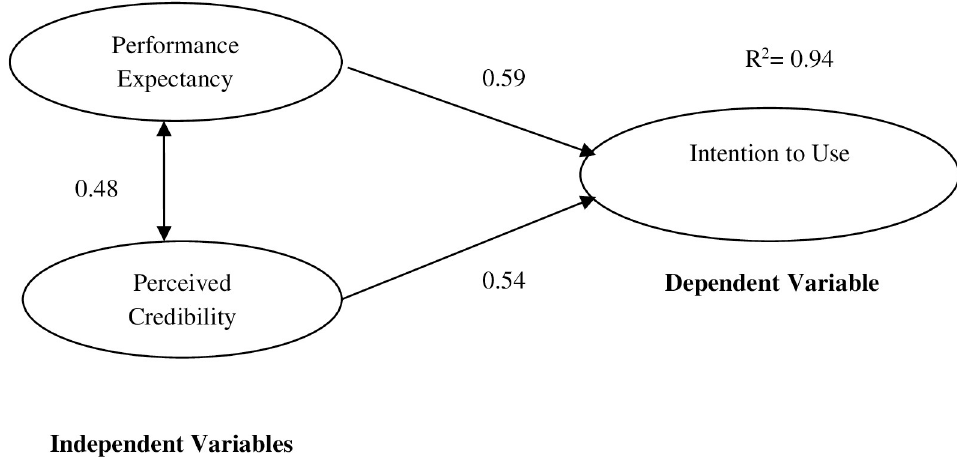
Fig 2. Structural model for male